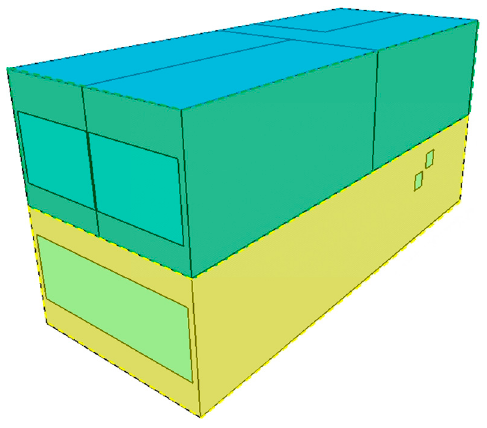
Figure 6. Project scale statistics of investigated container project cases around China.